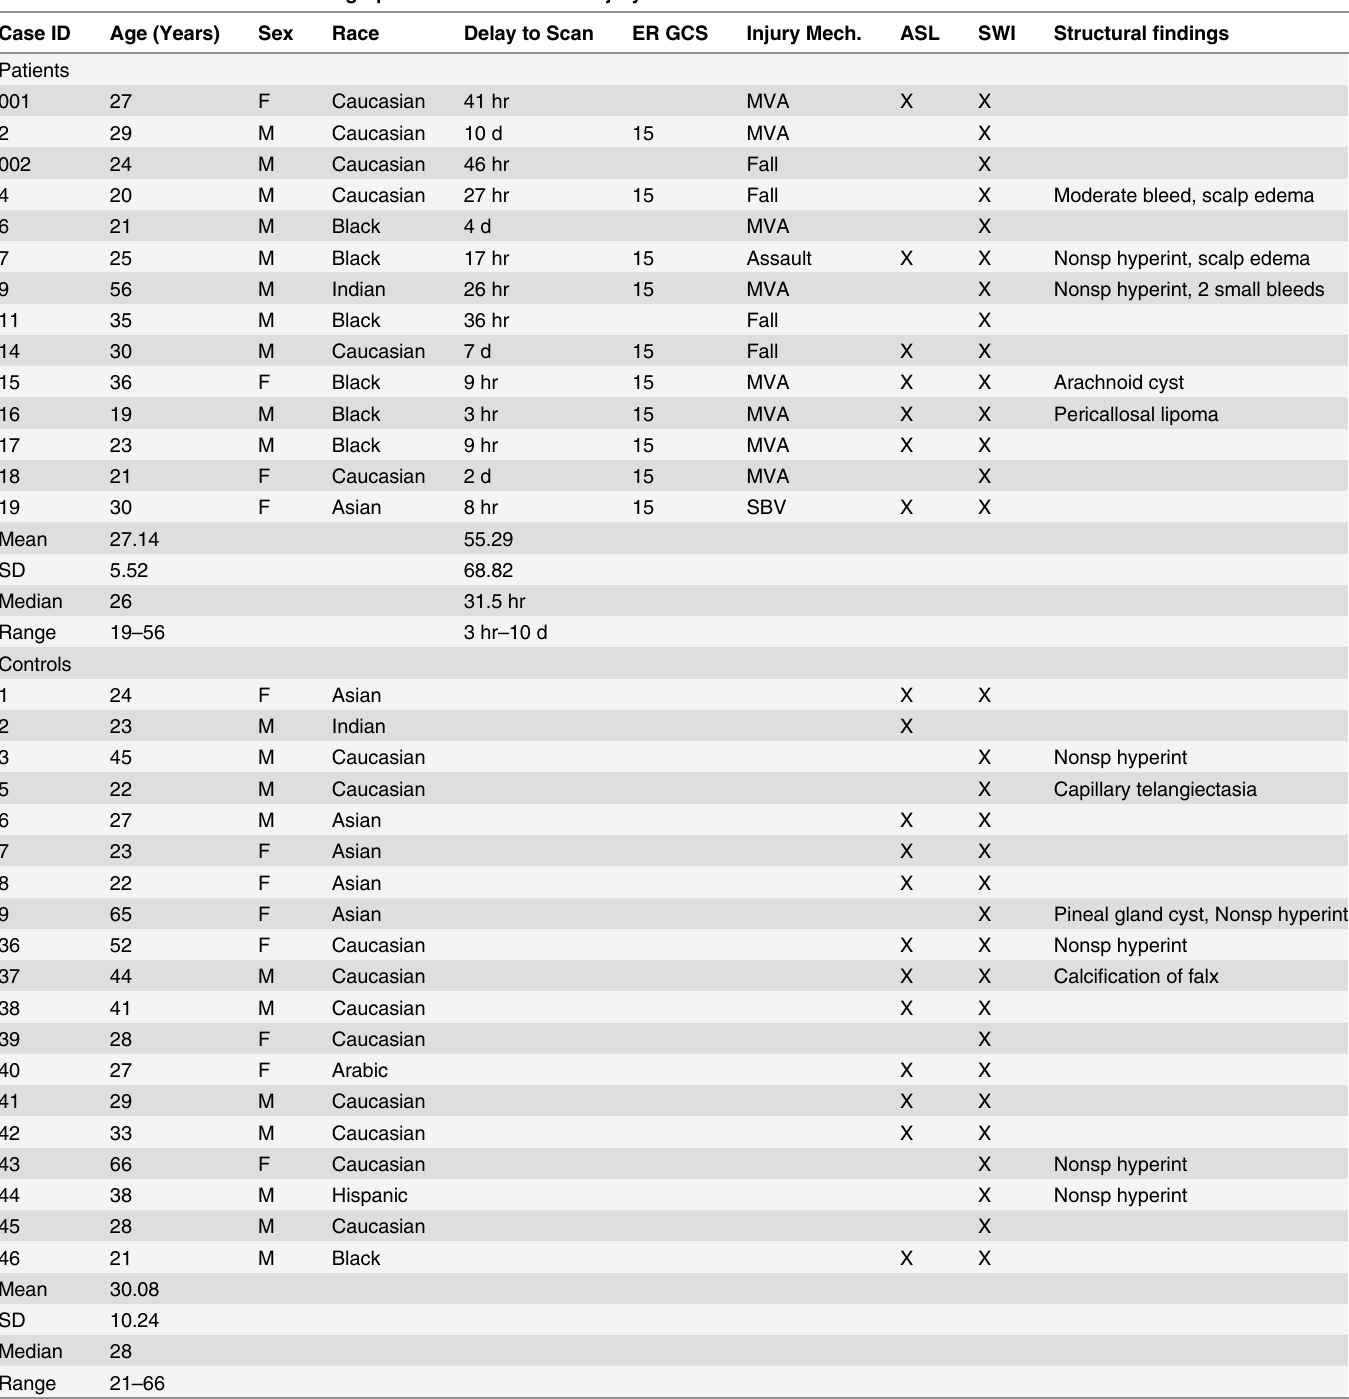
Table 1. Patients ’ and controls ’ demographic data and cause of